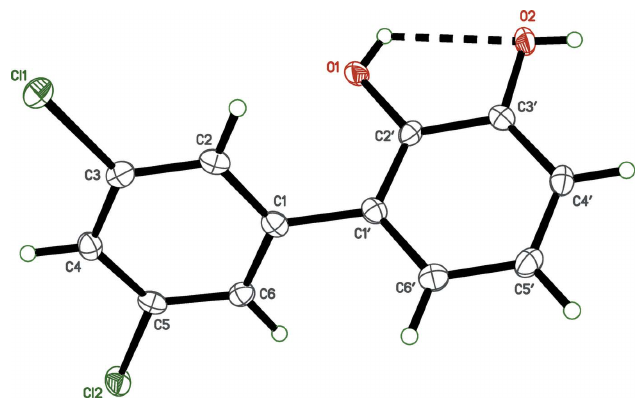
Figure 1 View of the title compound showing the atom-labelling scheme. Displacement ellipsoids are drawn at the 50% probability level. The intramolecular hydrogen bond is shown as a dashed line. For information regarding the hydrogen-bond geometry, see Table